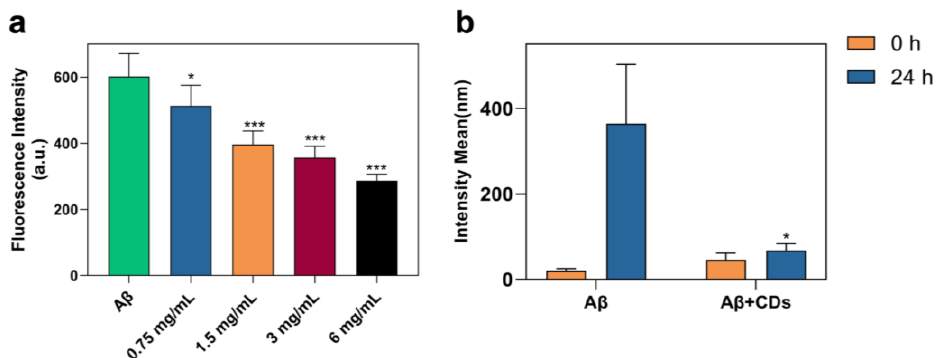
Figure 4. A β 1–42 aggregation was inhibited by N-CDs. ( a ) The thioflavin T fluorescence intensity in the presence or absence of N-CDs at the concentration of 0.75, 1.5, 3, and 6 mg/mL after 24 h incubation. *** p < 0.001, * p < 0.05 vs. A β 1–42 alone (1st column). ( b ) DLS spectra of A β 1–42 peptide with or without N-CDs (6 mg/mL) at the beginning and after 24 h incubation. The aggregation of the A β 1–42 peptide was inhibited in the presence of N-CDs after 24 h incubation compared with the free A β 1–42 peptide (* p < 0.05).